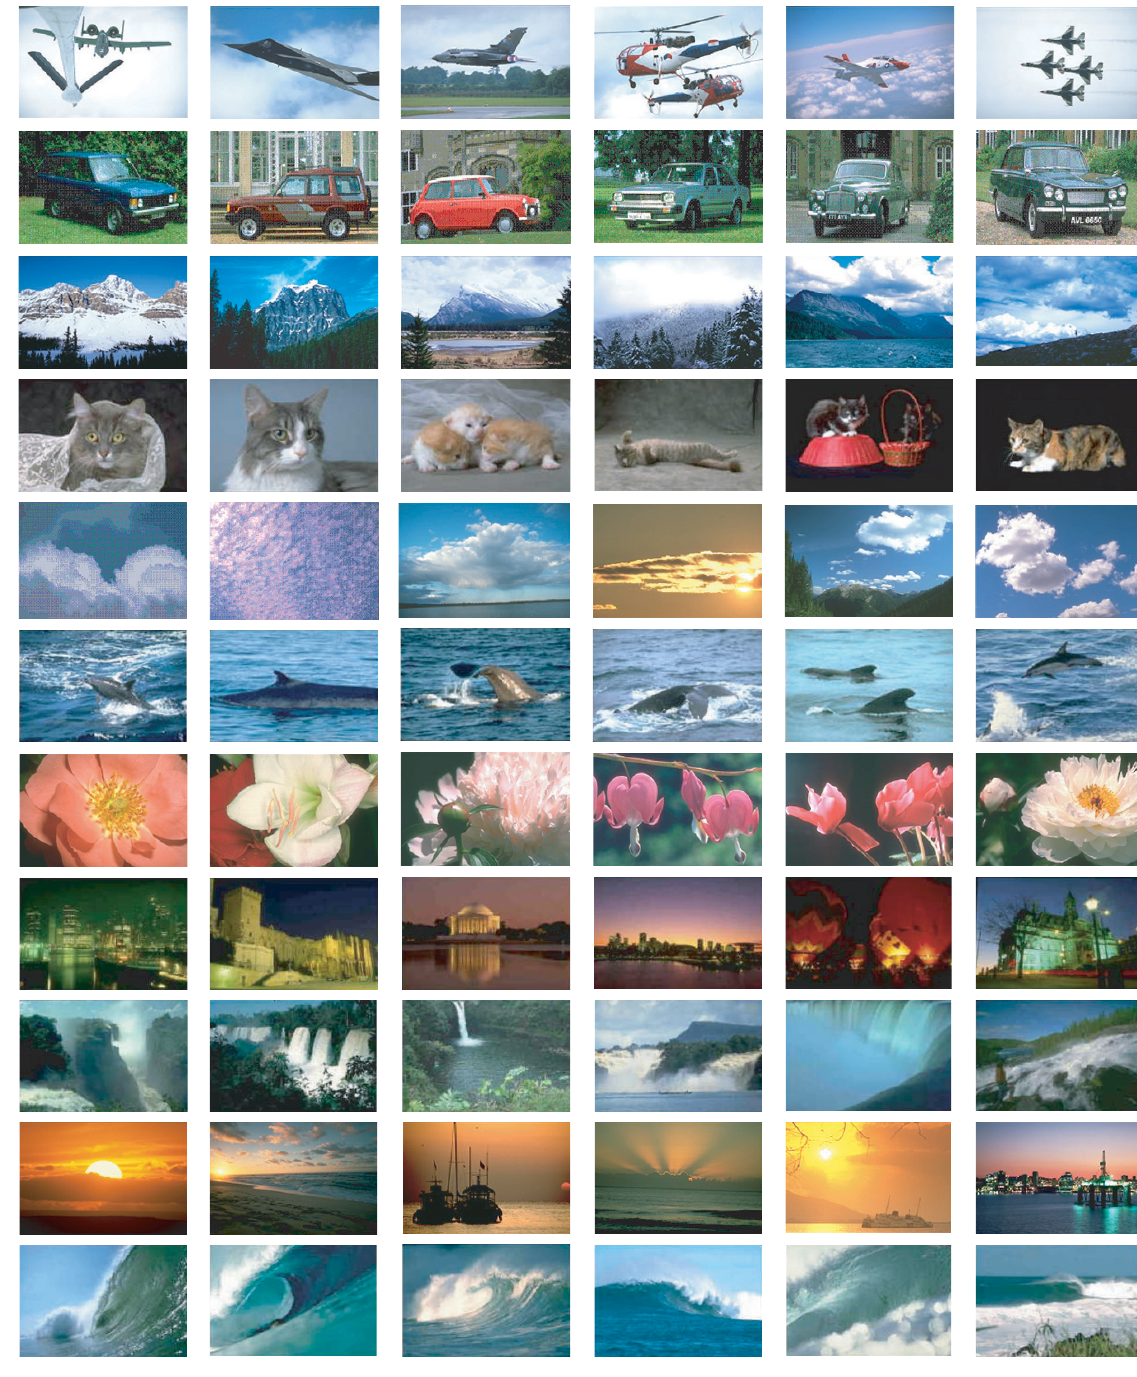
Figure 1: Sample images from various